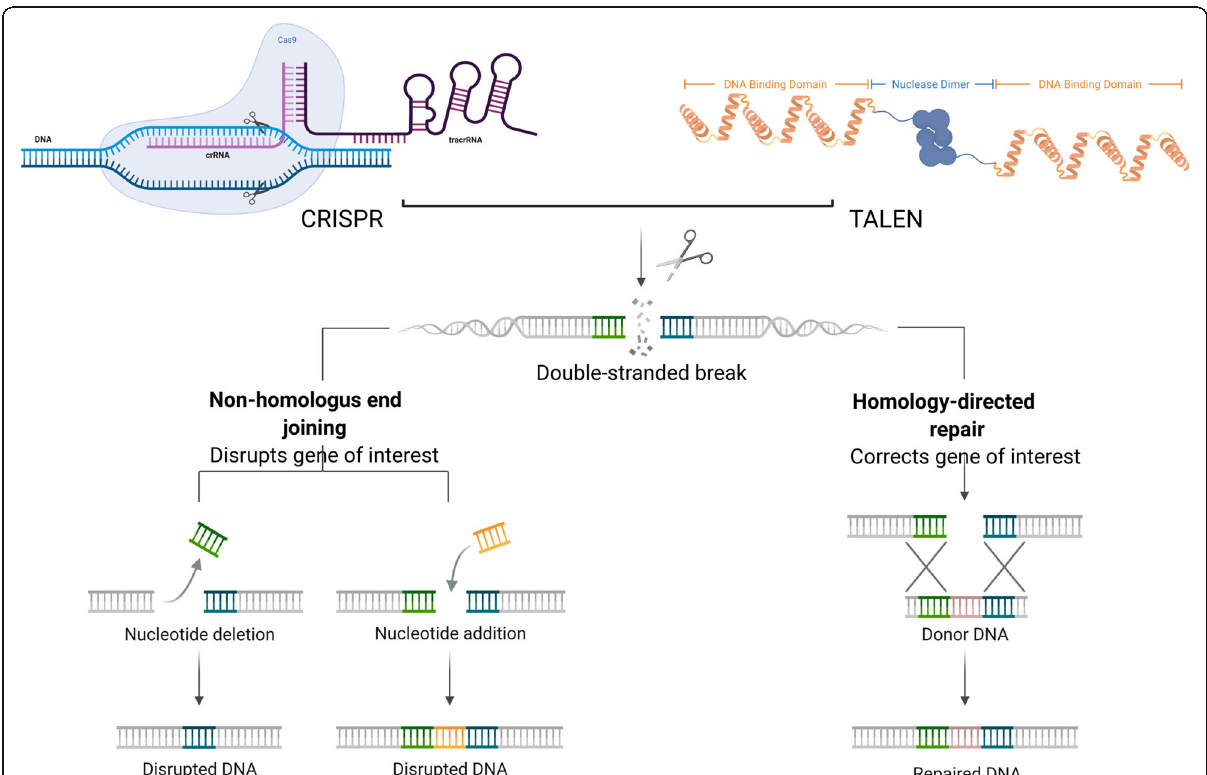
Fig. 1 Schematic illustration of genome editing nucleases inducing double-strand break (DSB) in target DNA. DSBs activate the DNA repair pathways: the error-prone nonhomologous end joining (NHEJ) or accurate but template dependent homologous recombination